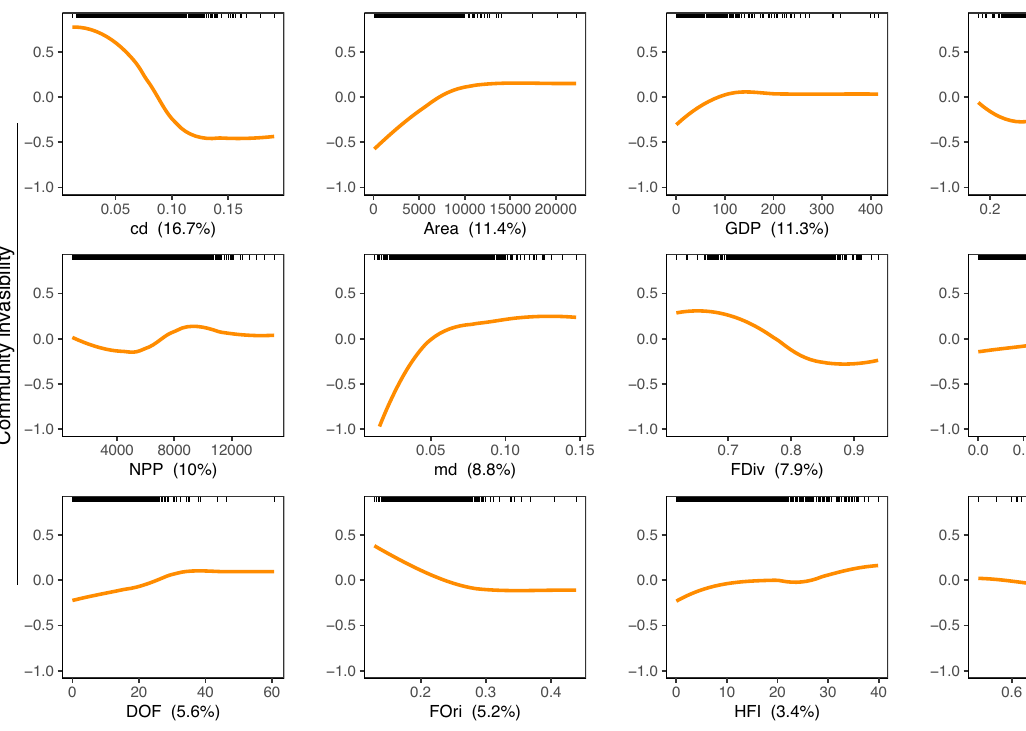
Fig. 3 | Results of boosted regression trees showing the partial dependency between fi sh community invasibility and predictors related to recipient com- munityfunctionalstructure,distancebetweeninvasiveandnative fi shspecies, environment,andhumanactivities. Thevalueinparenthesesineachpanelshows thepercentageofcontributionofeachpredictorconsideredinthemodel.Therugs inthetopofeachpanelshowthedistributionofthewatershedsalongthepredictor